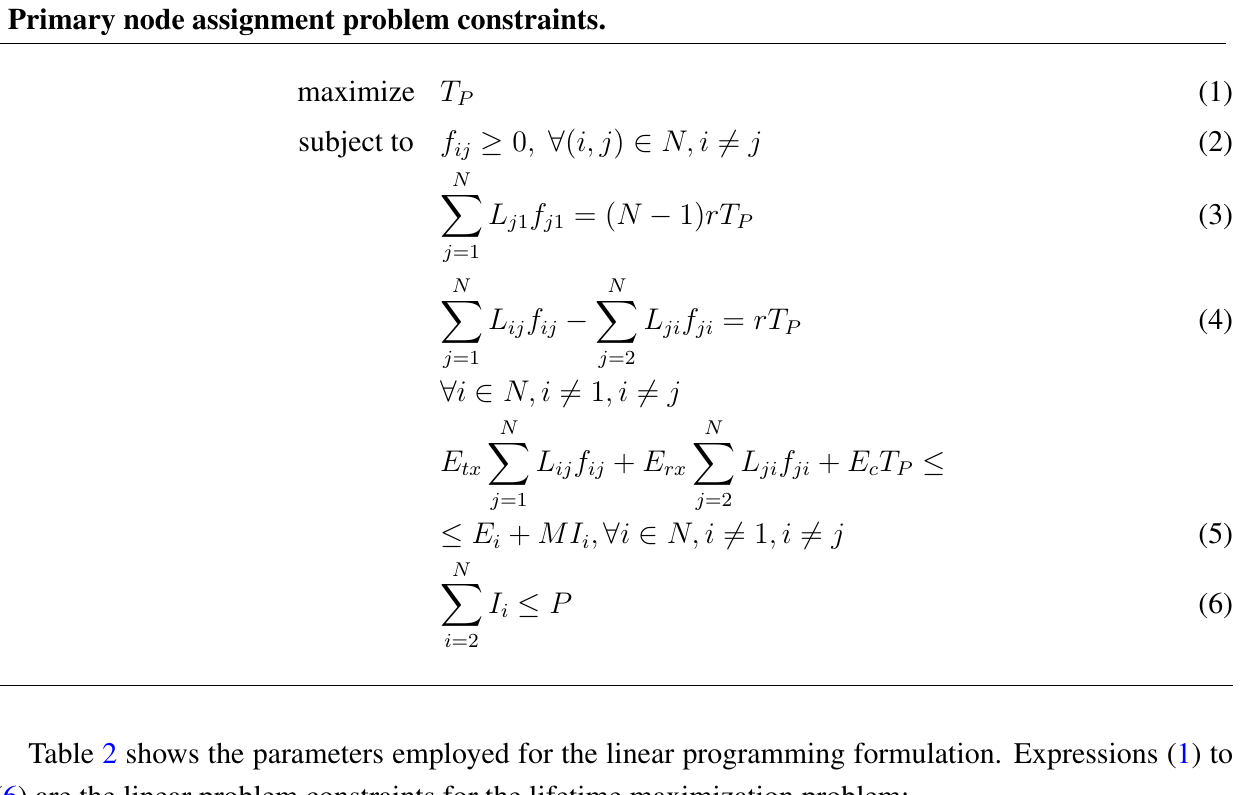
Table 1. Problem formulation of primary node